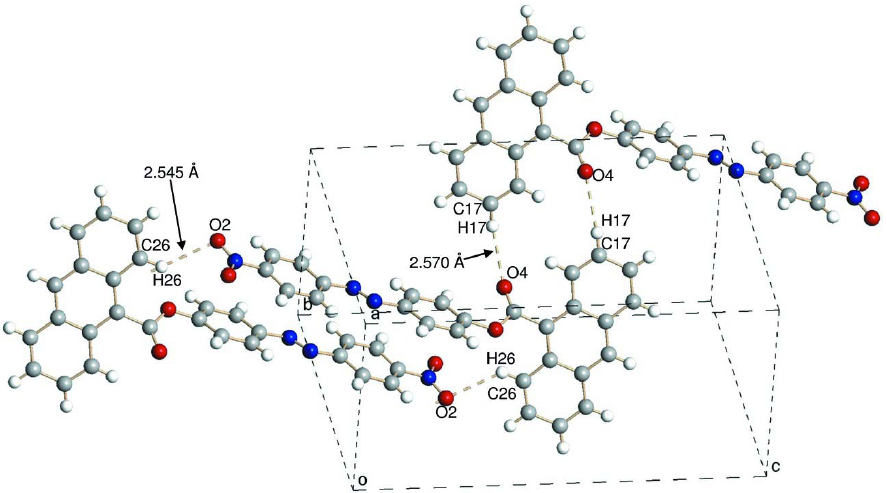
Figure 2 A packing diagram of (I) illustrating weak C—H···O hydrogen-bond interactions associated with terminal oxygen atoms O2 and